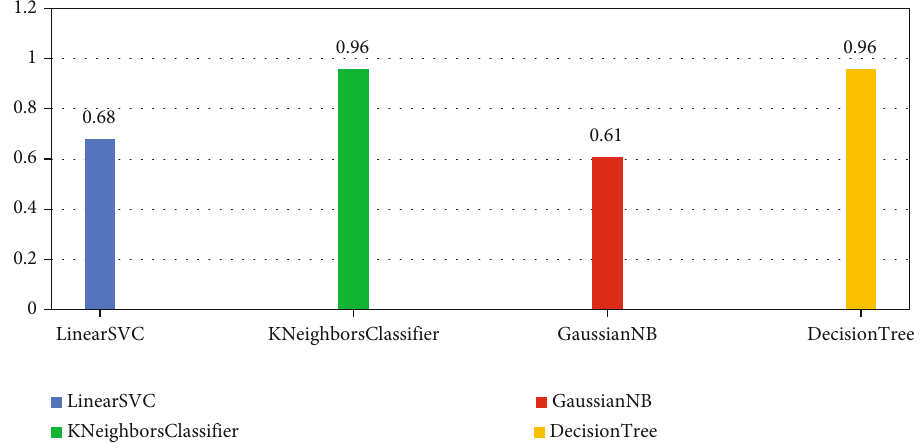
Figure 7: Results of training of four classi fi ers with the generated dataset. Table 4: Classi fi cation precision of DecisionTree for bitrate classes. Precision Bitrate